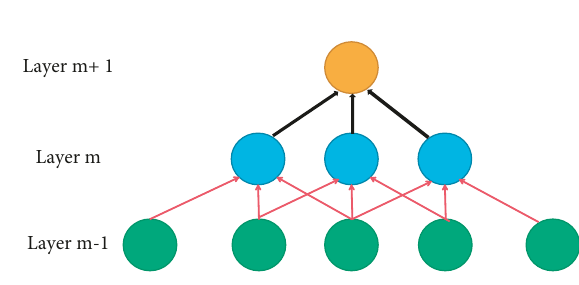
Figure 2: Convolutional neural network model.